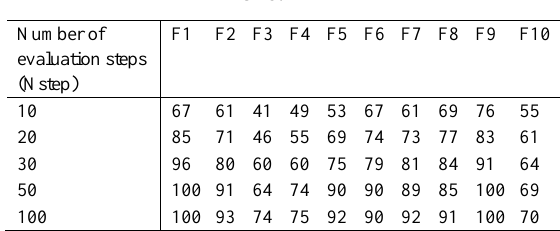
Table 9. Number of evaluation steps for different Nstep